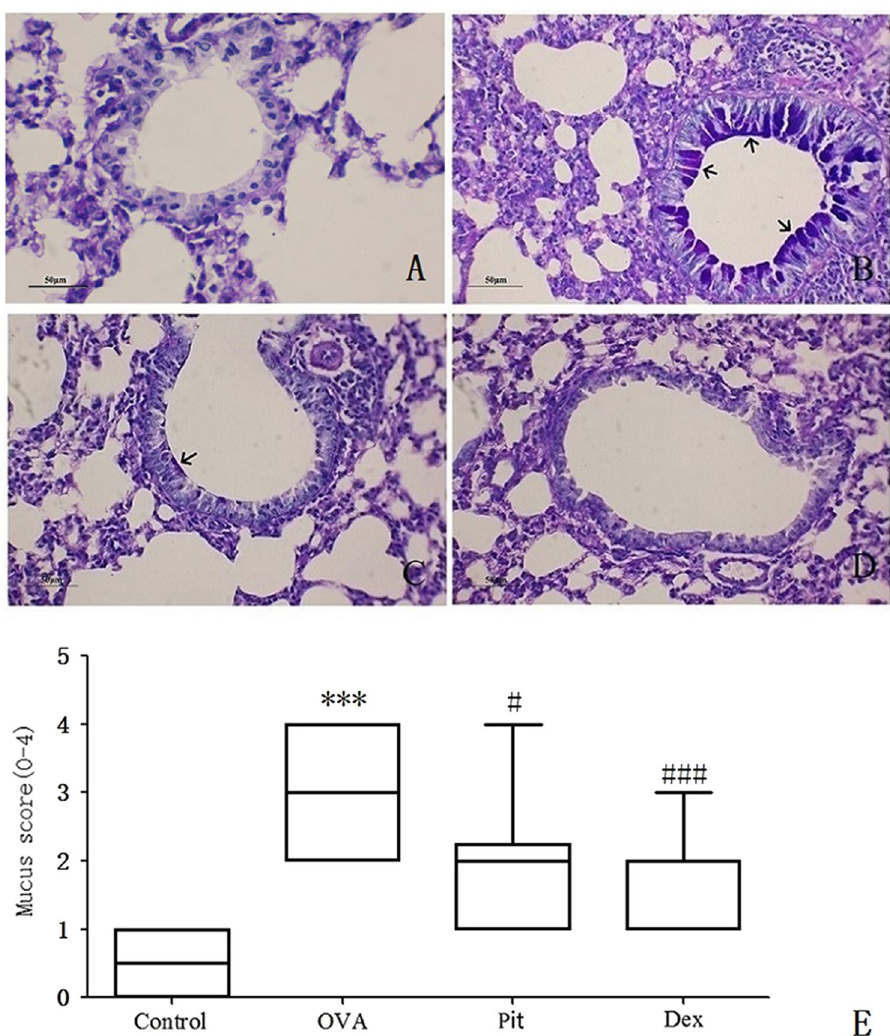
Figure 5. Histological images of airways stained with PAS for goblet cell (dark red in the lumen) (n = 10 per group) visualization. ( A ) Control mice treated with aerosolized PBS. ( B ) Mice challenged with OVA and treated with PBS. These mice displayed significantly increased numbers of goblet cells in their airway epithelia compared with control mice. ( C ) Mice challenged with OVA and treated with inhaled pitavastatin. ( D ) Mice challenged with OVA and treated with i.p. injections of dexamethasone. Mice treated with pitavastatin or dexamethasone displayed significantly less goblet cells than those challenged with OVA. These panels depict the histological features representative of each condition in seven or eight mice per group. ( E ) Kruskal-Wallis one- way analyses of mucus production in the lung sections were performed according to the methods developed by Myou and Lee 48, 49 . *** P < 0.001 compared with the control group; # P < 0.01 compared with the OVA